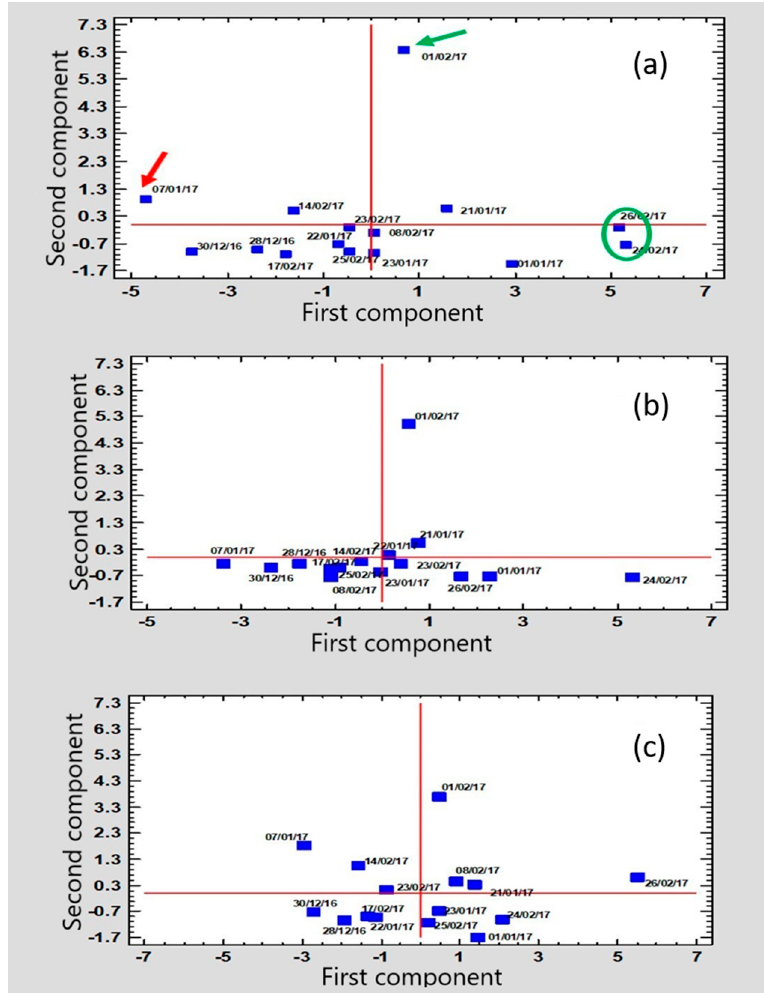
Figure 3. Scatterplot with scores from statistical analysis of the different sampling days by principal component analysis (PCA). ( a ) represents the whole data set computed as variables. ( b ) represents the data of the majority elements. ( c ) represents the data of the trace elements. The green circle, and red and green arrows indicate values that are out of the general behavior.